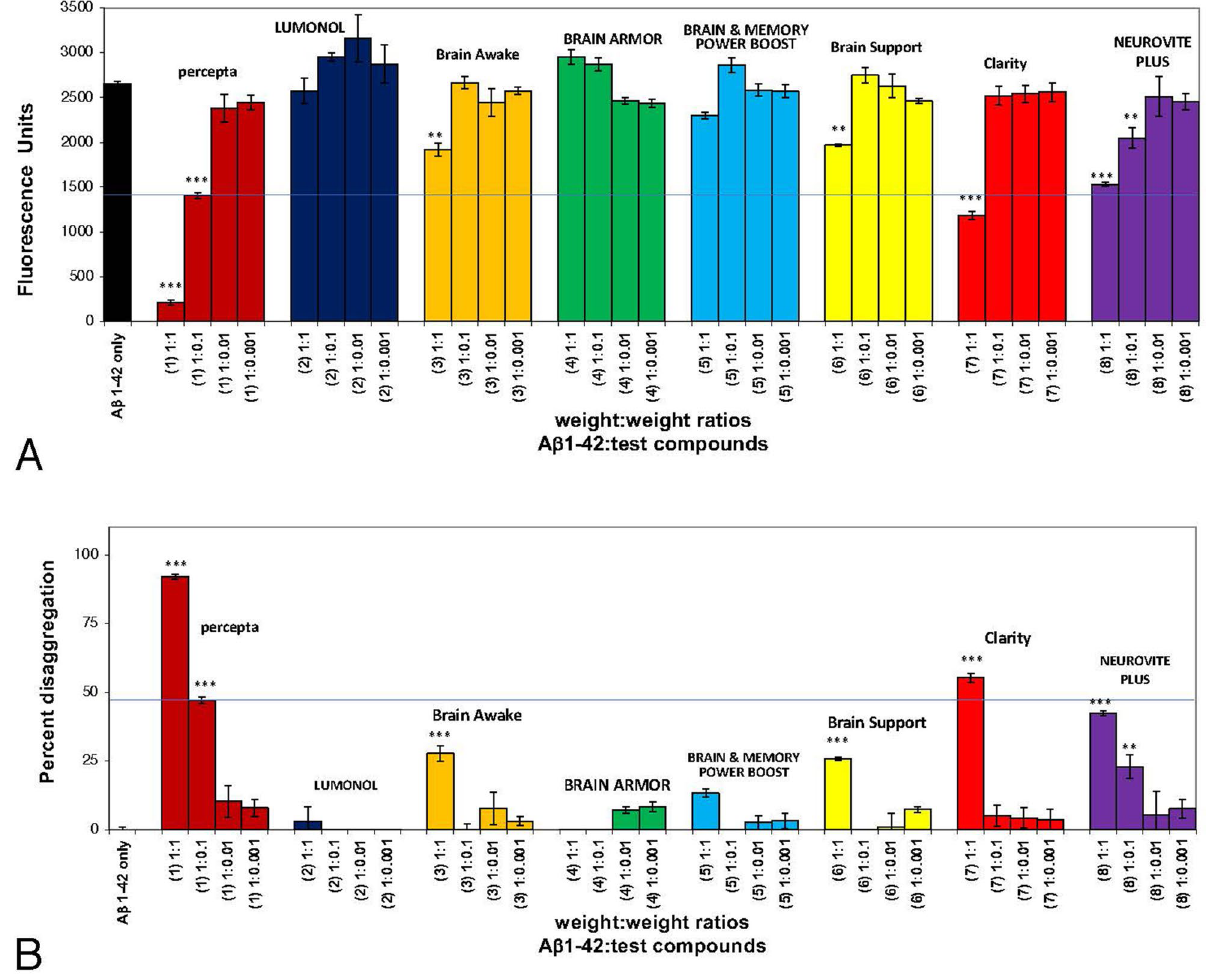
Figure 2. Percepta was the most potent disrupter of Aβ 1–42 fibrils in comparison to seven (7) other top-selling brain supplements on a wt/wt basis. ( A ) Percepta was compared to LUMONOL, Brain Awake, BRAIN ARMOR, brainMD (BRAIN & MEMORY POWER BOOST), Brain Support, Clarity (BRAIN HEALTH FORMULA), and brainMD (Neurovite Plus). Percepta, once again was the most potent disrupter /disaggregator of pre-formed Aβ 1–42 fibrils than any other brain supplement tested as determined quantitatively by Thioflavin T fluorometry. Aβ 1–42 formed fibrils instantly and showed 2,654 Thioflavin T fluorescent units (FU)(black bar). Increasing doses of percepta (Aβ 1–42:percepta wt/wt ratios of 1:0.001, 1:0.01; 1:0.1; and 1:1 were tested) demonstrated a marked dose-dependent disaggregation/disruption of pre-formed Aβ 1–42 fibrils. All the other brain supplements tested did not reduce Aβ 1–42 fibrils or only somewhat did so at the highest 1:1 wt/wt dose tested. *p < 0.05, **p < 0.01, ***p < 0.001, by Student’s t-test. Bars represent mean ± SEM. ( B ) Comparison of percepta to 10 (ten) other memory-support supplements in % disaggregation of preformed Aβ 1–42 fibrils. Percepta , by far, had the most robust activity and reduced/disaggregated Aβ 1–42 fibrils in a dose-dependent manner (light brown bars). At a Aβ:percepta wt:wt ratio of 1:0.1 (blue line across graph), percepta disaggregated Aβ 1–42 fibrils by 4.29%, much better than any other brain supplement tested (see line across the graph). *p < 0.05, **p < 0.01, ***p < 0.001, by Student’s t-test. Bars represent mean ± Figure 6A and B demonstrated the formation of paired helical and straight filaments after 3 days of incuba- tion with Tau-441 with the highly sulfated glycosaminoglycan, heparin 5,32–37 . Paired helical filament formation appeared identical to that seen in brain aging and AD 5,32–37 . These pre-formed tangles help compare the effects of different memory-support supplements for disaggregation/reduction of pre-formed tau tangles using quantitative Thioflavin T fluorometry as described below. As shown in Fig. 6C, tangle formation was confirmed by Thioflavin T fluorometry at day 3 to reach 3,600 fluorescent units (black bar on left). Percepta was identified as the most potent disrupter of tau protein tangles in comparison to the other ten (10) memory-support dietary supplements on a wt/wt basis and in a dose-dependent manner (tau: dietary supplement ratios tested of 1:0.001, 1:0.01; 1:0.1 and 1:1) (Table 1). Increasing doses of percepta demonstrated a significant dose-dependent disaggregation/disruption of pre-formed tau tangles at the two highest doses tested (i.e. 1:0.01 and 1:1 wt/wt) (Fig. 6C, D). Tau tangle reduction at 1:0.1 wt/wt clinical dose